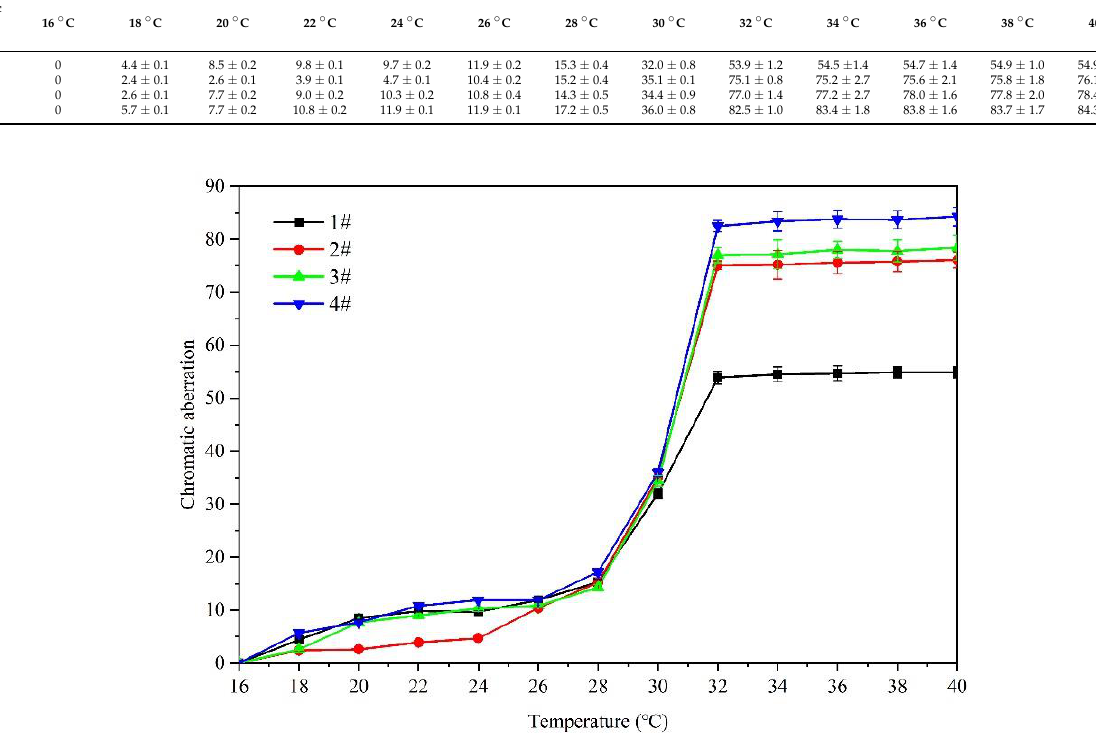
Table 4. The temperature rise (16 °C to 40 °C) on colorimetric aberration of film.